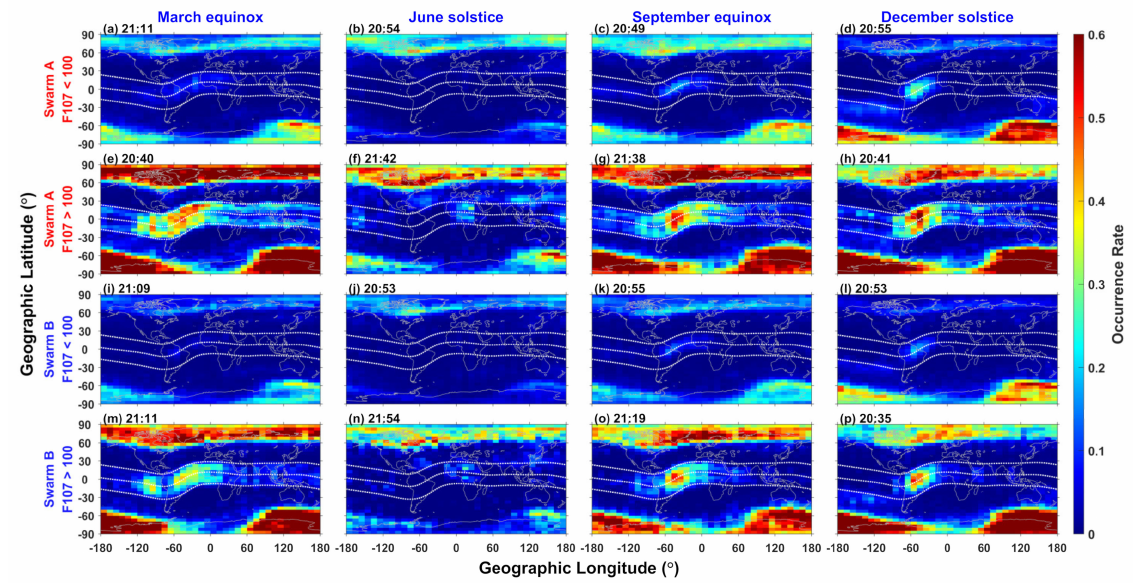
Figure 3. Same as Figure 2 but for ROTI. The panels from top to bottom show results for Swarm A (F107 < 100, ( a – d )), Swarm A (F107 > 100, ( e – h )), Swarm B (F107 < 100, ( i – l )), and Swarm B (F107 > 100, ( m – p )), from left to right show results at March equinox, June solstice, September equinox, and December solstice.